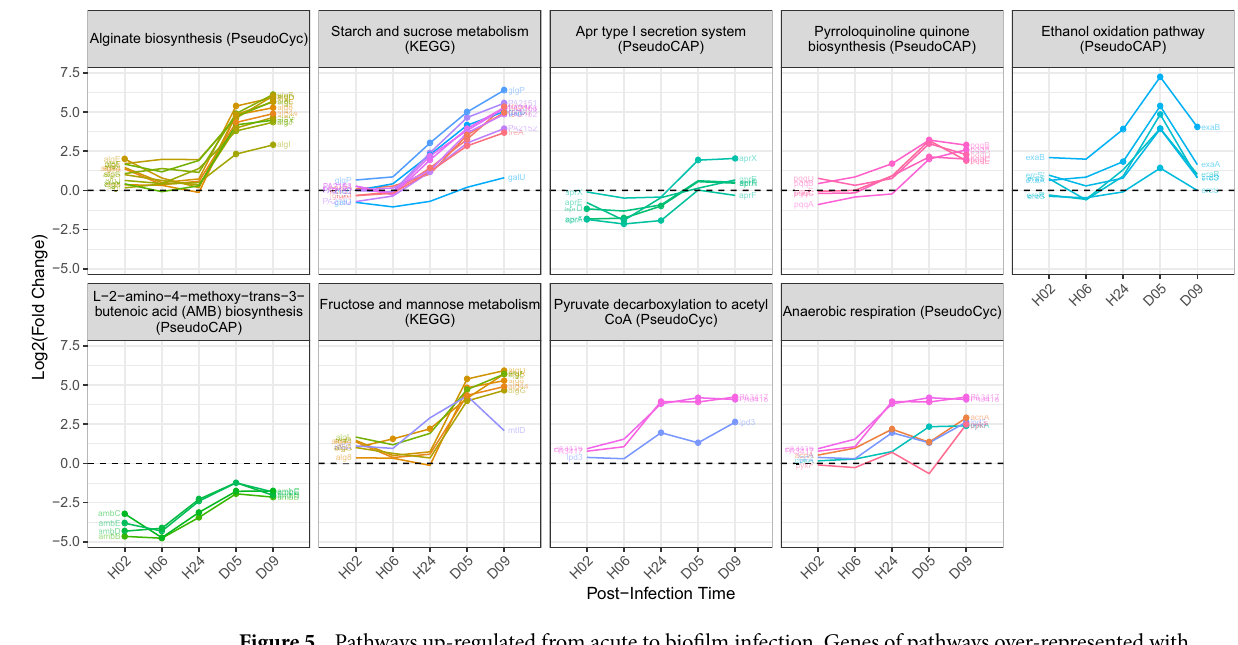
Figure 5. Pathways up-regulated from acute to biofilm infection. Genes of pathways over-represented with up-regulated genes (D5&D9:H2&6) are plotted vs. in-wound time (Log2FC is in-wound vs. culture). Dashed lines indicate the expression level in log-phase culture. Solid circles indicate a significant gene expression difference (FDR < 0.05) between log-phase culture and wounds at each post-infection time.